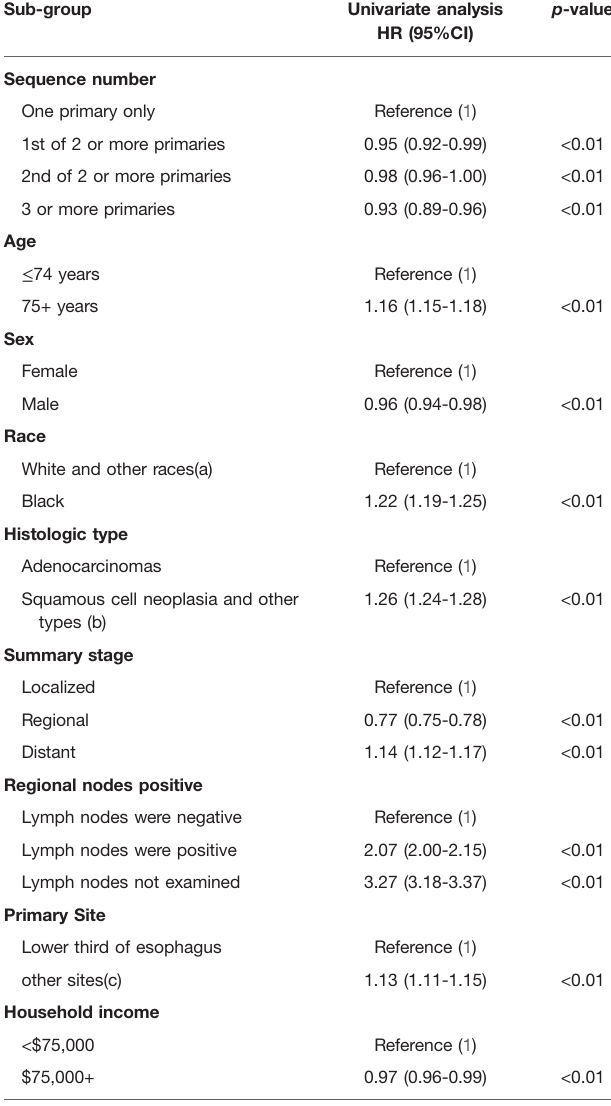
TABLE 4 | Univariate Cox proportional hazards analysis of esophageal cancer based on the SEER database. Sub-group Univariate